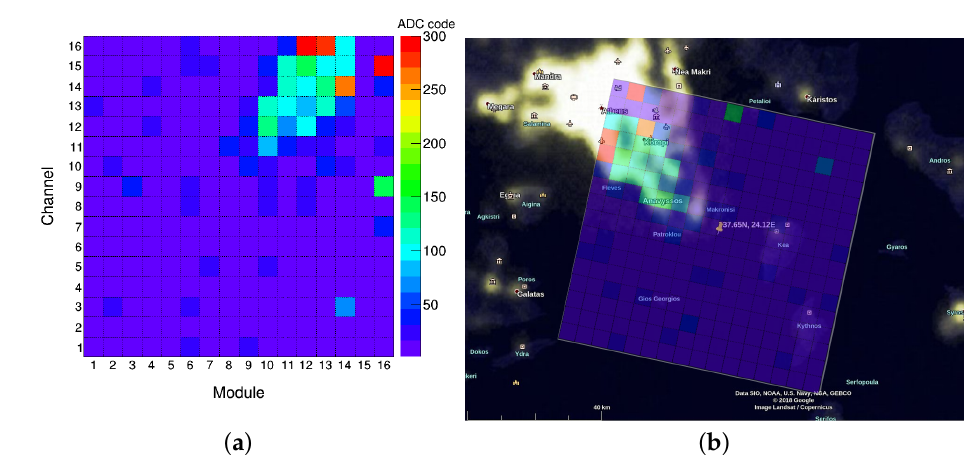
Figure 16. ( a ): a snapshot of the focal plane of an event registered above anthropogenic lights, see the text for details. ( b ): a snapshot of the focal plane adjusted to the TUS geographical position and orientation and superimposed on the Google map around Greece.